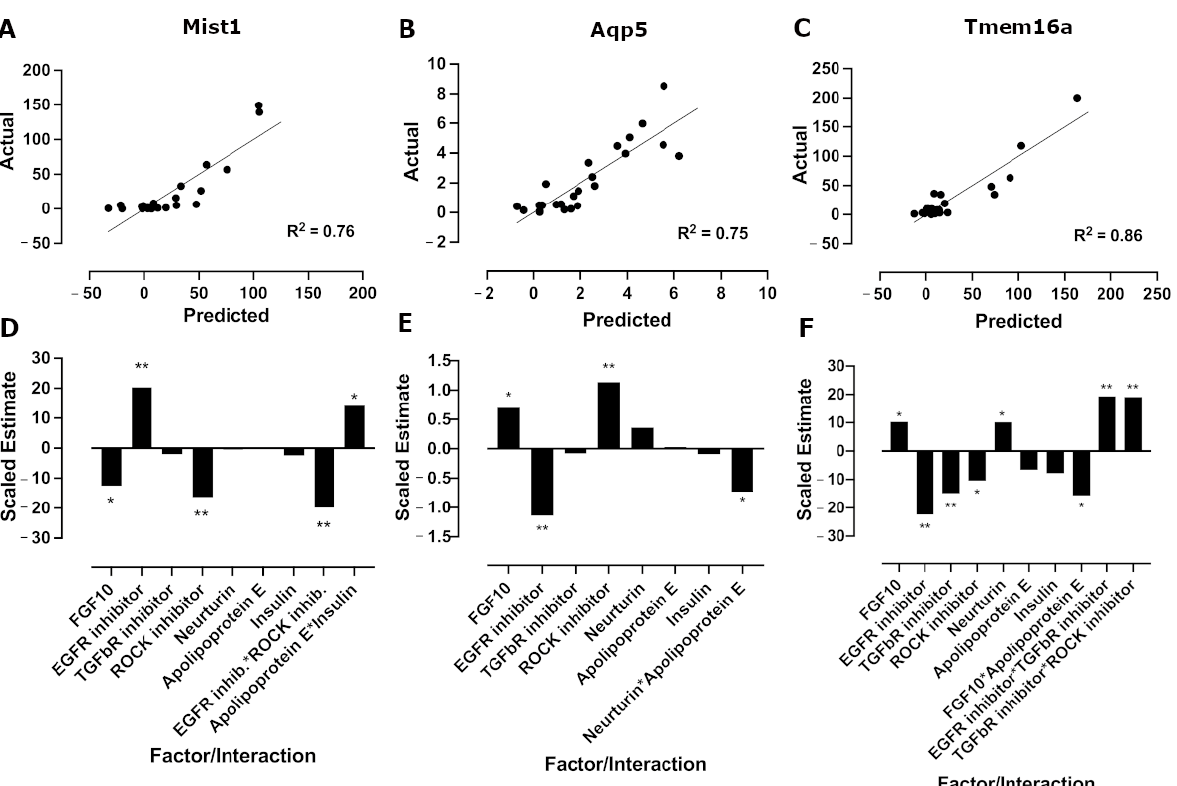
Figure 3. EGFR inhibitor, FGF10, neurturin, and ROCK inhibitor increase relative mRNA expression. Scatter plot of the predicted (model) values against the actual (experimental) mRNA expression with best fit line and R 2 values for Mist1 ( A ), Aqp5 ( B ), and Tmem16a ( C ) for the Plackett–Burman DoE. Linear regression was used to determine the best fit line and R 2 values. Main effects plots showing the scaled estimates of factors and significant interactions for Mist1 ( D ), Aqp5 ( E ), and Tmem16a ( F ). p -values were determined using one-way ANOVA with Benjamini–Hochberg post-hoc test. * p < 0.05; ** p < 0.01.